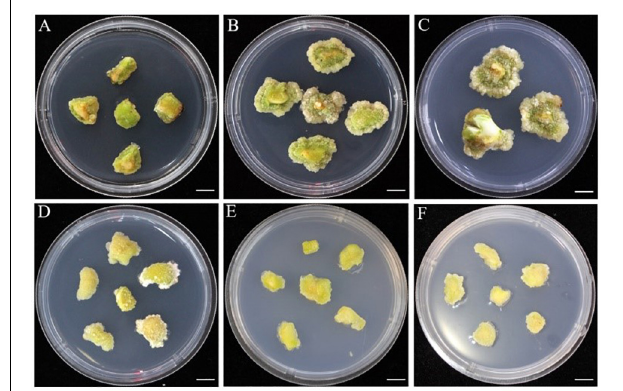
FIGURE 3 | The phenotype of callus induced 50 days after inoculation under combined with 2,4-D and TDZ in E1 medium. (A) Induced callus status